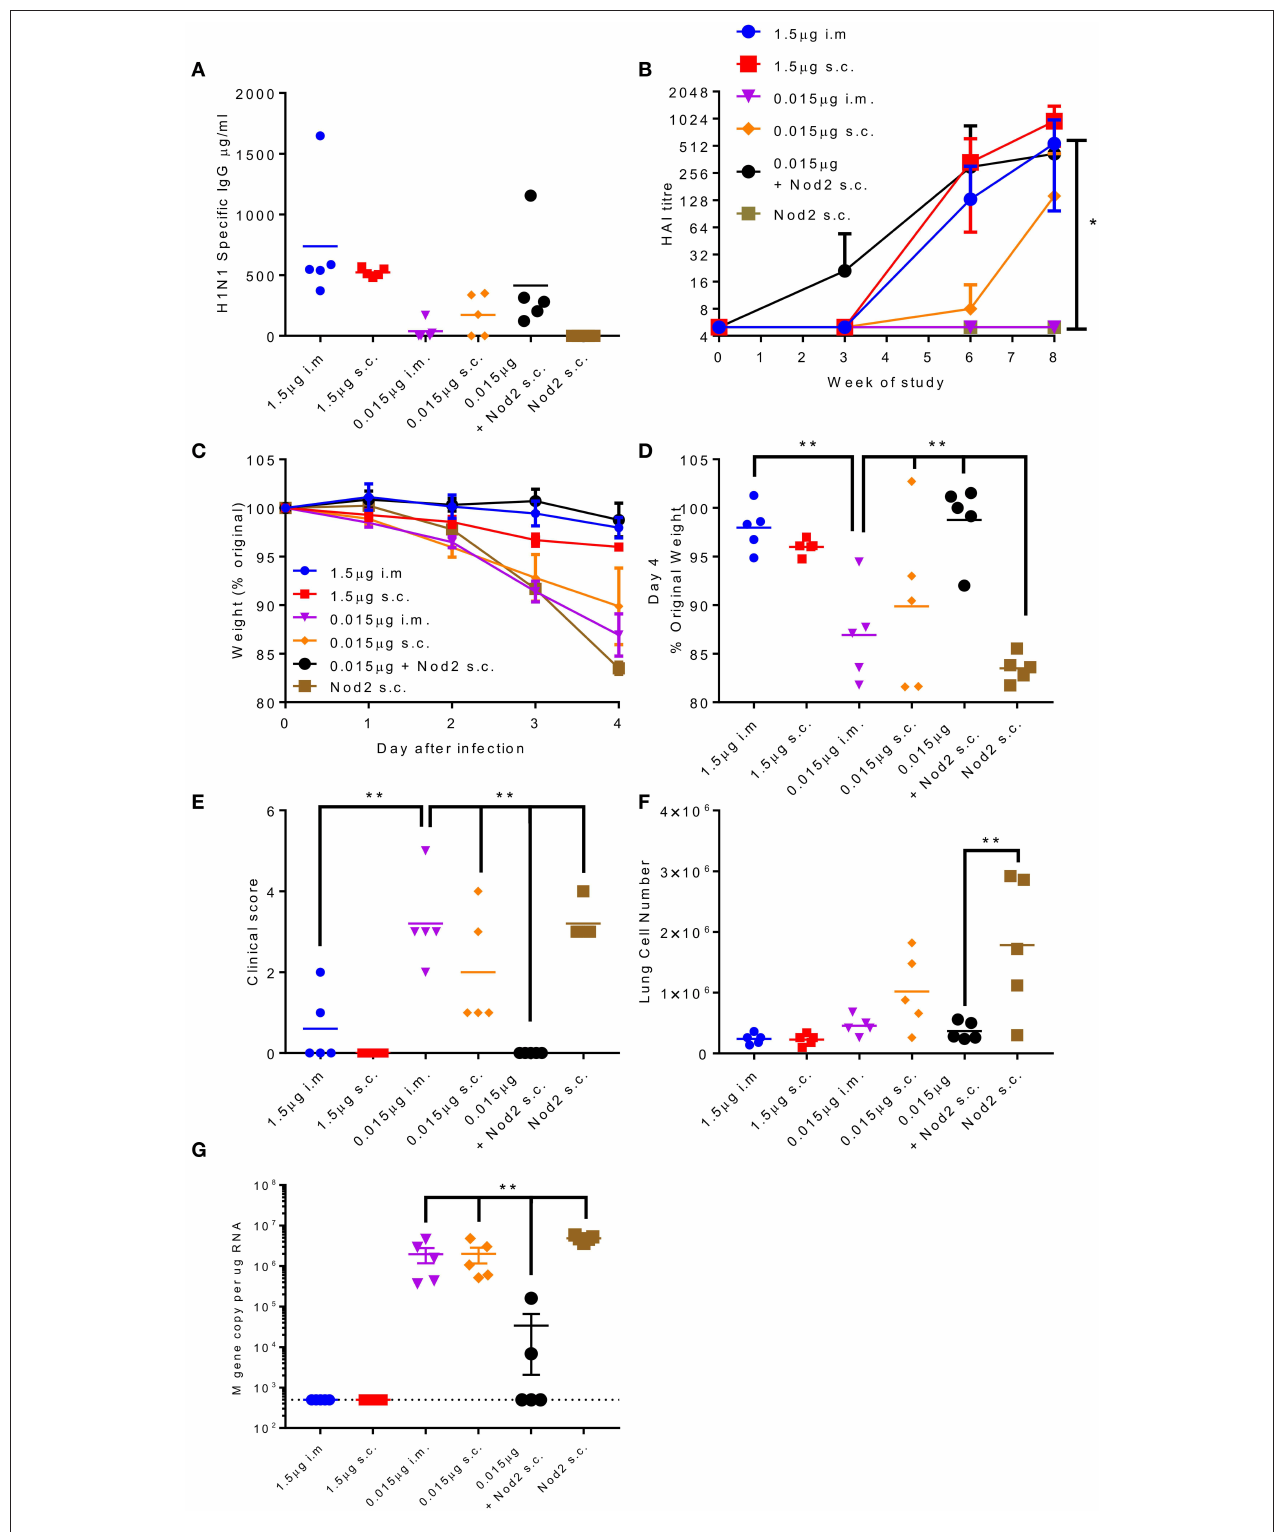
FIGURE 6 | Combination of antigen with PLA-Nod2 particles enables dose sparing. Mice were immunized three times at 3 weekly intervals with 1.5 or 0.015 µ g ciliate derived rHA A/Cal by the intramuscular (i.m.) or subcutaneous (s.c.) routes; responses were compared to 0.015 µ g antigen loaded onto PLA-Nod2 particles or